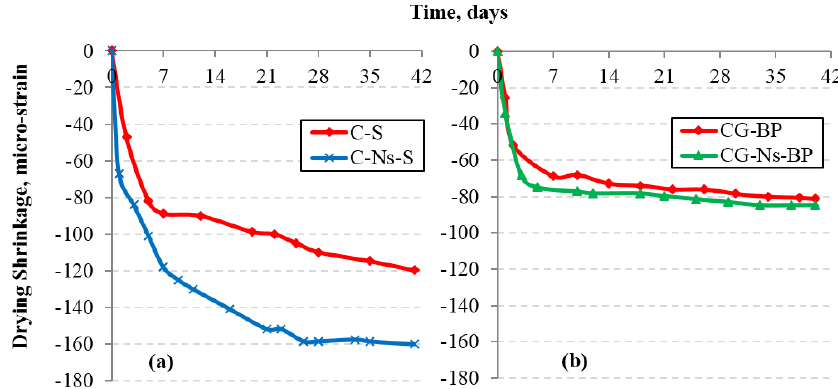
Figure 2. Effect of nano-silica on the drying shrinkage of NFRM: ( a ) OPC; and ( b ) OPC/GGBS binders.